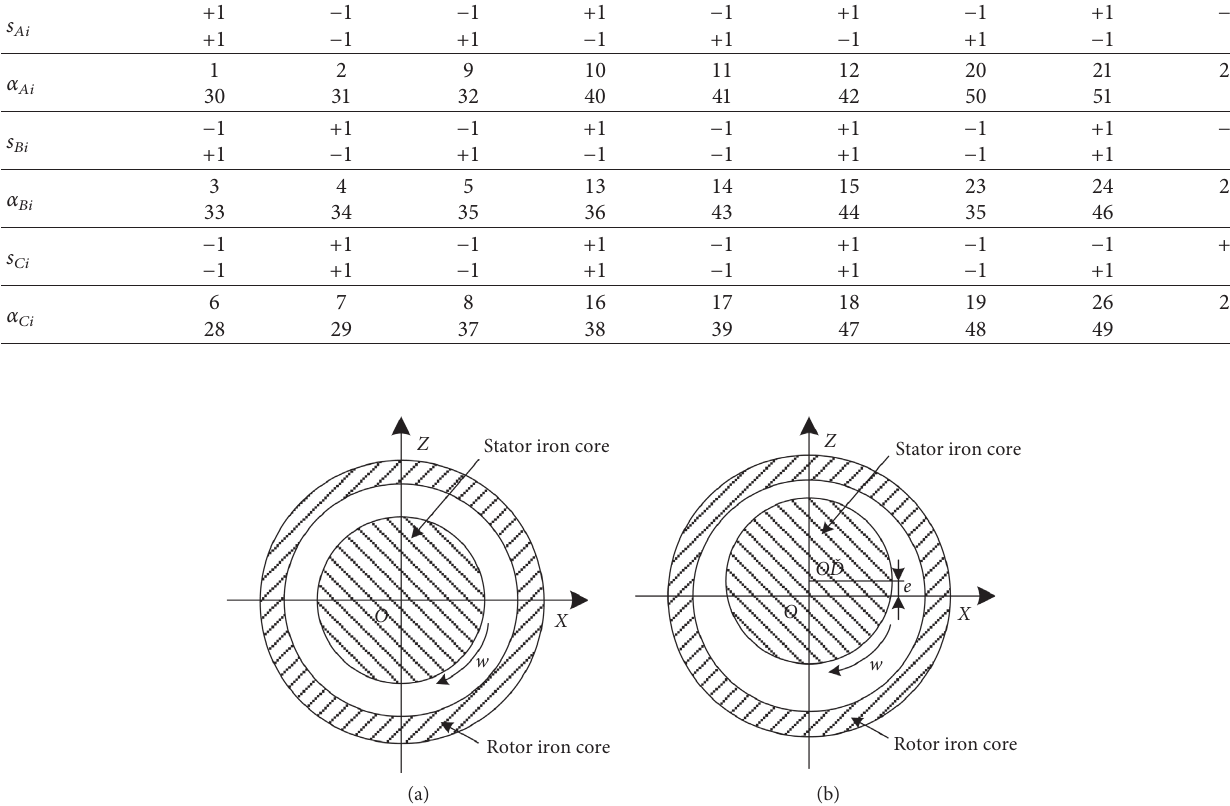
Figure 4: Eccentricity diagram of the stator and rotor. (a) Noneccentric state. (b) Eccentric